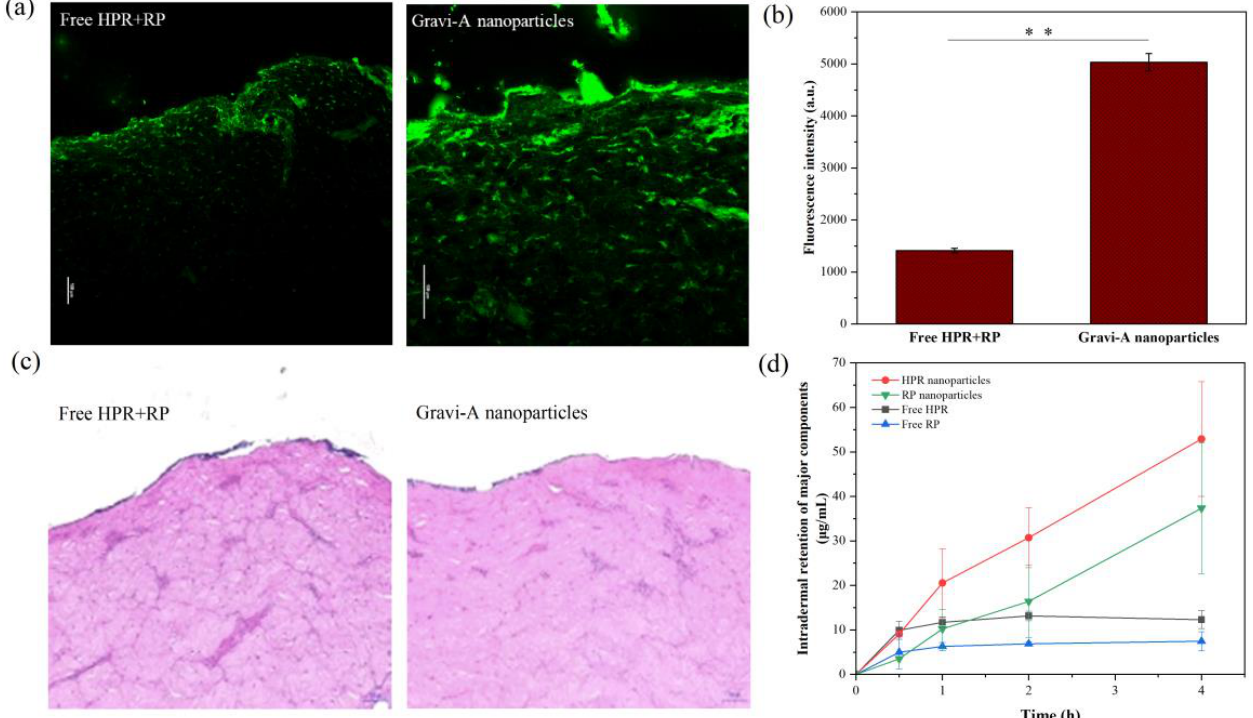
Figure 4. Skin penetration and biocompatibility of free HPR + RP and supramolecular Gravi − A nanoparticles. ( a ) CLSM images (scale bars: 100 μm); ( b ) Comparison of fluorescence intensity; ( c ) H&E-stained sections of porcine skin after treatment (scale bars: 100 µ m, ** p < 0.01); ( d ) Cumulative penetration of the main components in porcine skin.